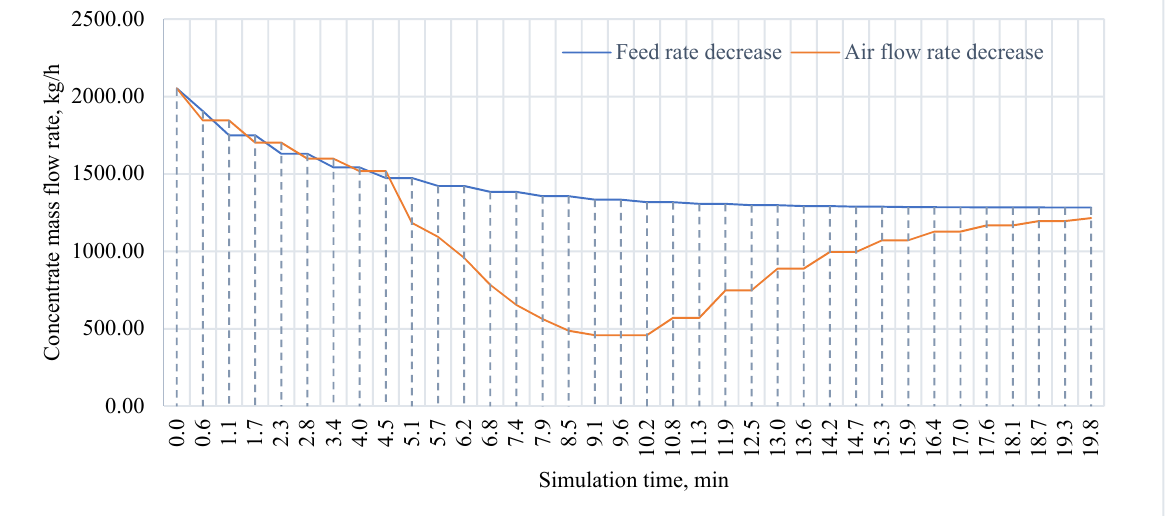
Figure 10. FeAsS concentrate grade.